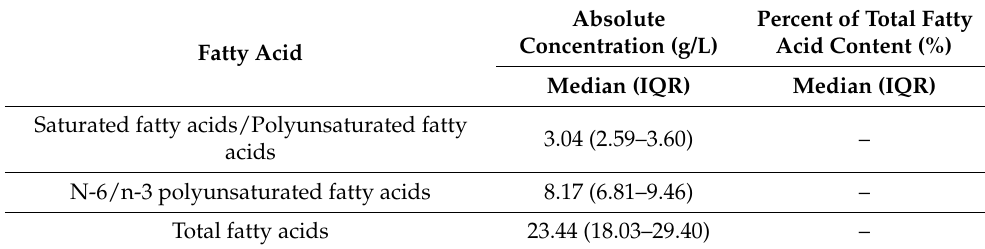
Table 4. Notable maternal predictors of triglyceride fatty acid percent composition in milk from Norwegian mothers 1 .